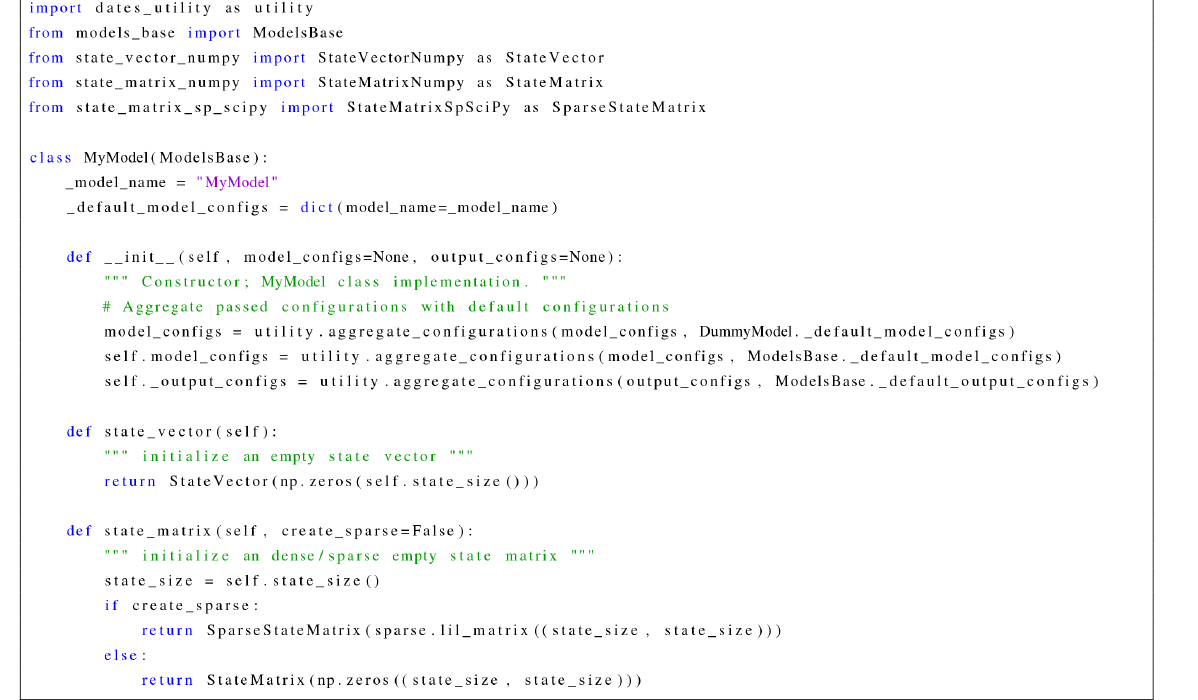
Figure 18. The leading lines of an implementation of a class for the model MyModel derived from the models’ base class ModelsBase . Linear algebra objects are derived from NumPy-based (or SciPy-based)